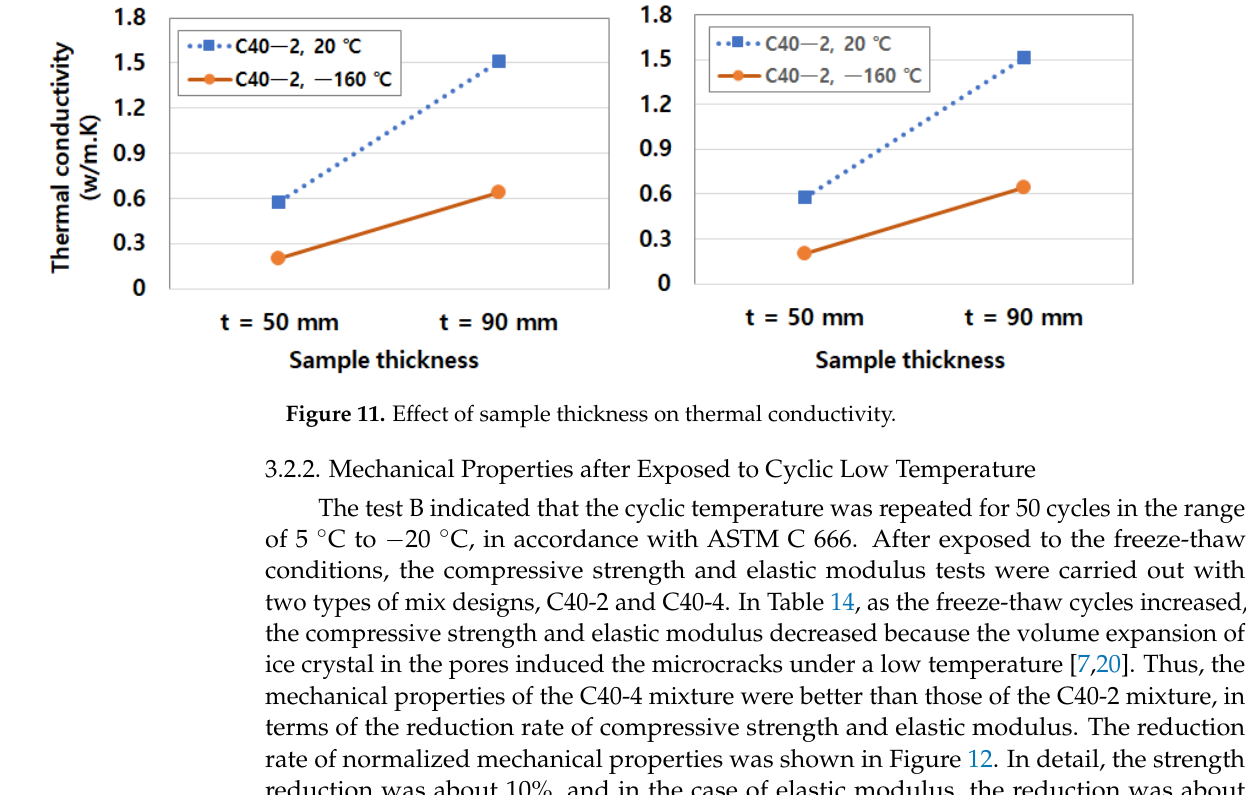
Table 13. Test results of thermal conductivity. Test Item